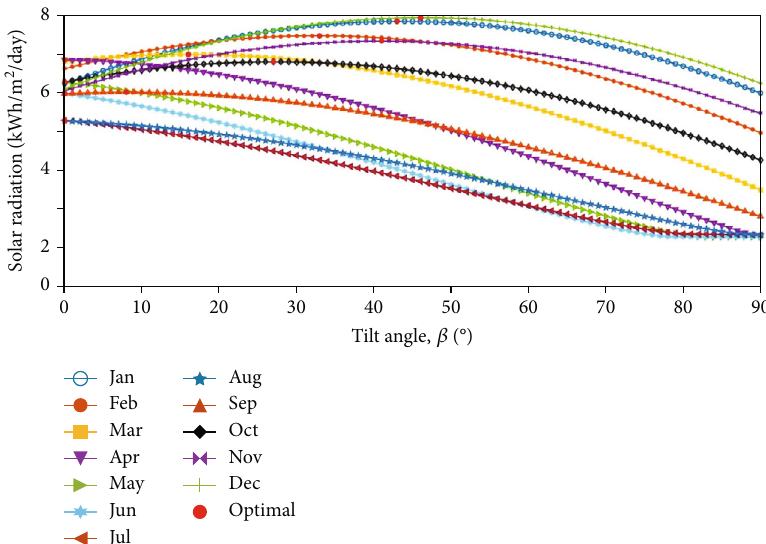
Figure 5: Monthly average daily solar radiation availability and an optimal value of a tilted surface using an anisotropic model of equation (19), Bahir